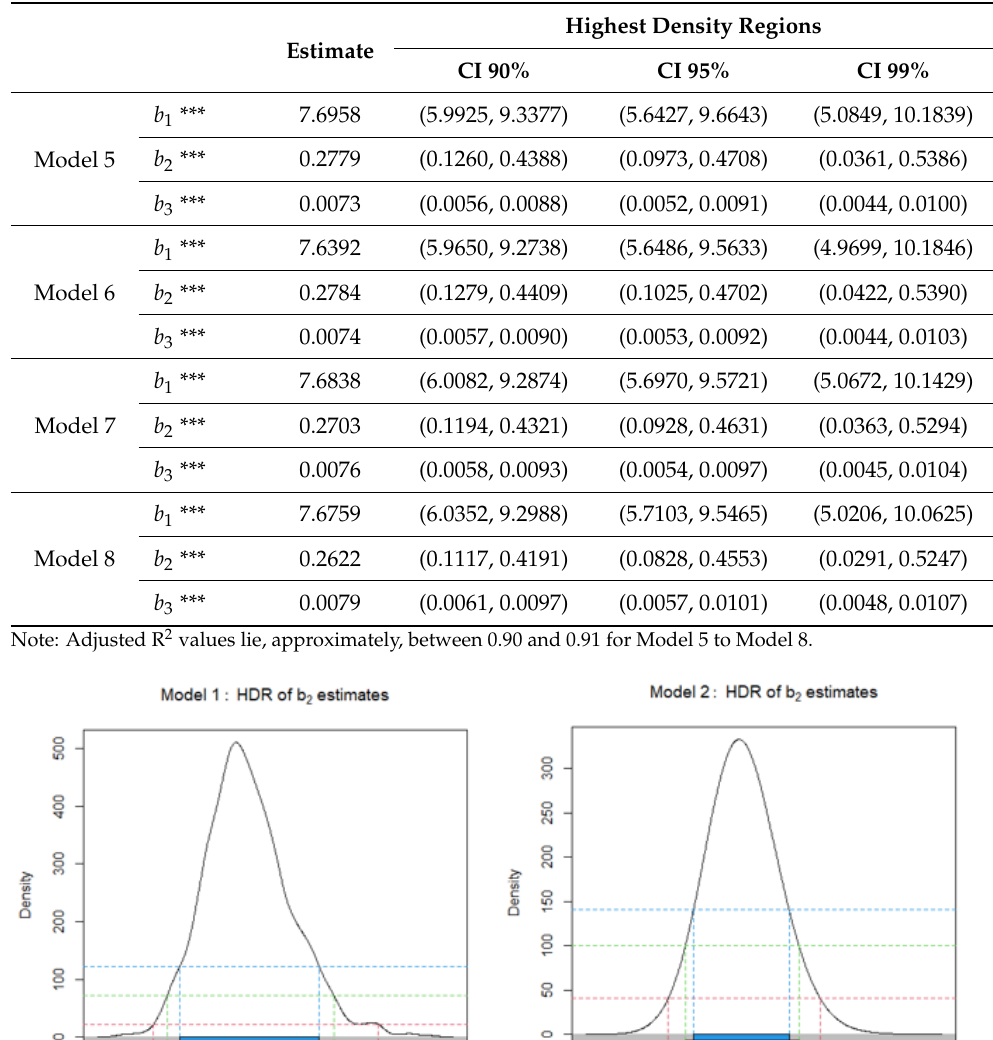
Table 7. Results for Model 5 to Model 8 (data from 1959 to 2019).